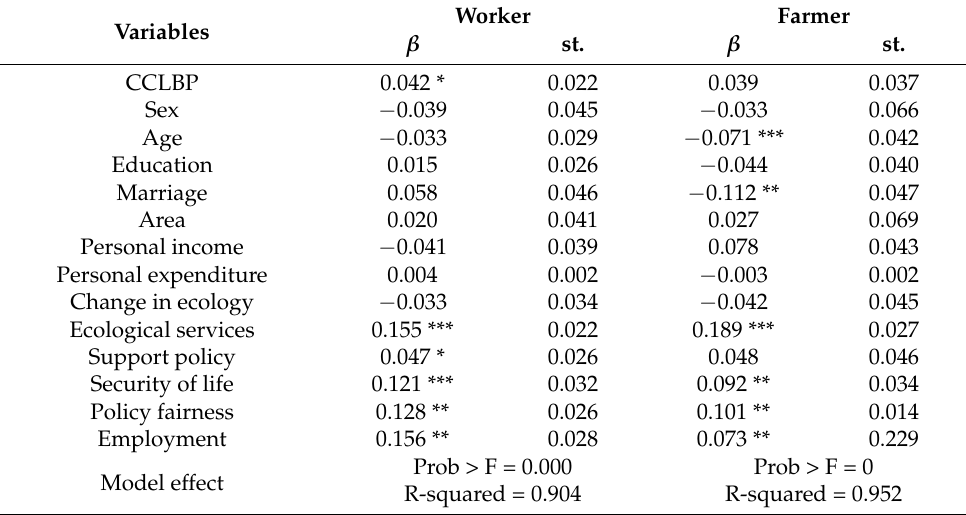
Table 9. Regression results of life satisfaction in different occupational types. Variables